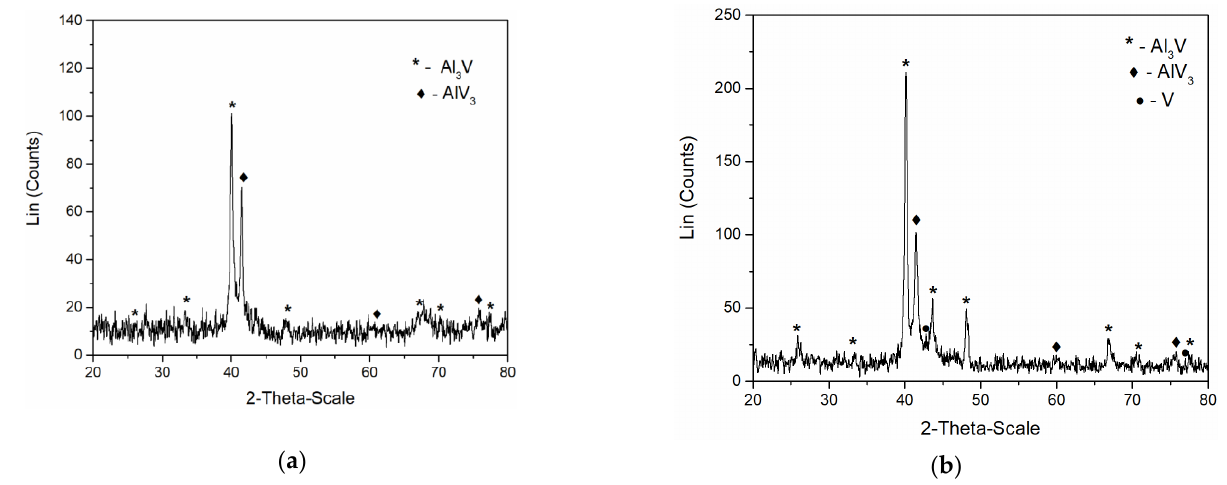
Figure 9. XRD patterns of electrochemically produced deposit on GC working electrode at 200 ◦ C; deposition time 5 h: ( a ) from the equimolar AlCl 3 + NaCl melt containing anodically dissolved V at 0.020 V vs. Al; ( b ) from the equimolar AlCl 3 + NaCl with vanadium added by VCl 3 at 0.050 V vs. Al.